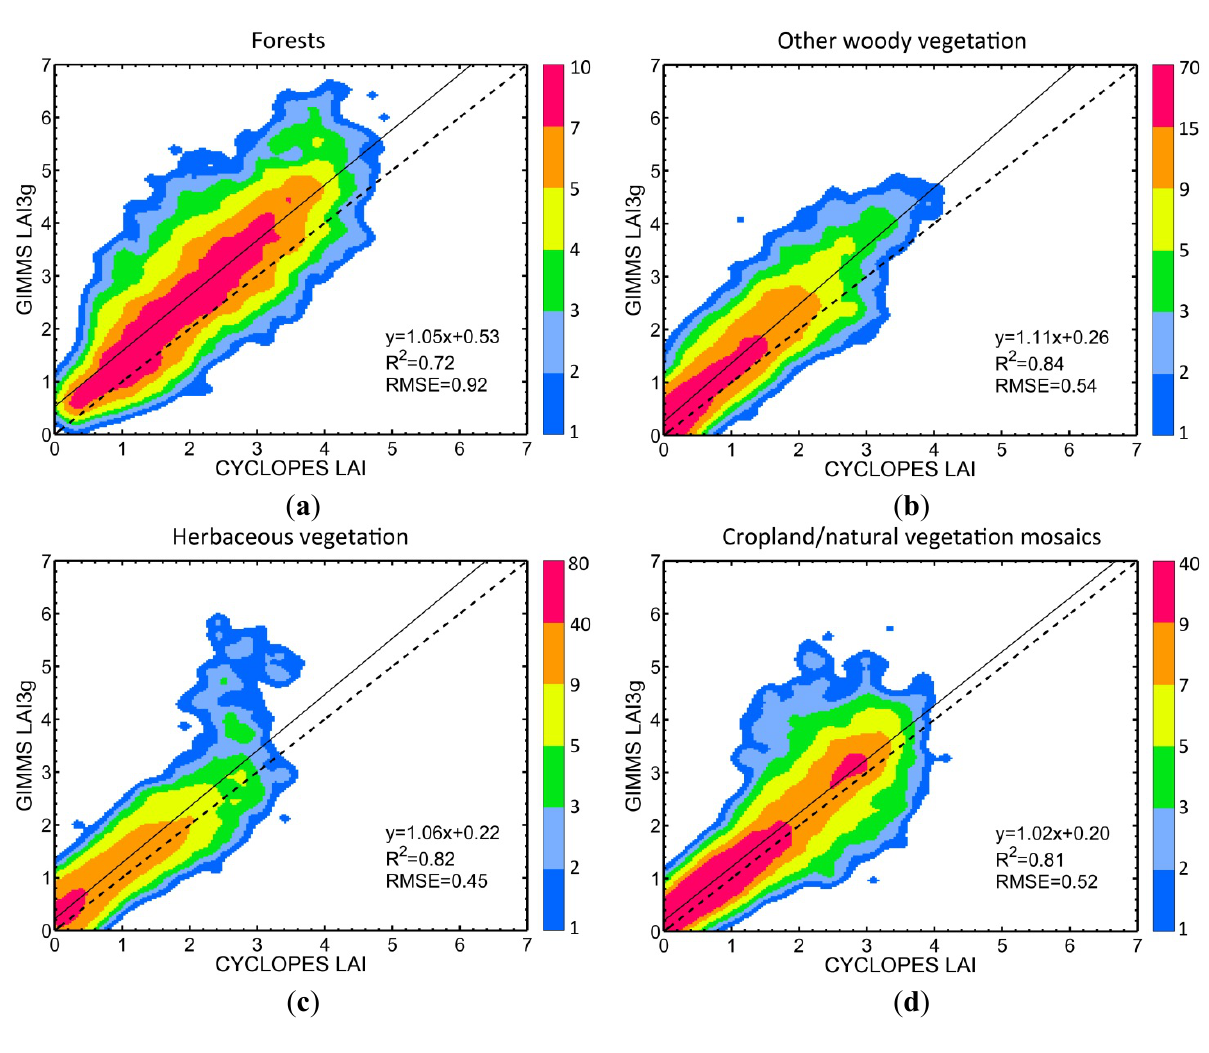
Figure 4. Density scatter plots of monthly LAI3g and CYCLOPES LAI for 323 BELMANIP sites for the time period from 1999 to 2007. The plots show correlation between the two products for four broad groups of vegetation which are grouping of the IGBP land covers (Table S5). The black dash line is the 1:1 line. The solid black lines are regression lines derived from the scatter